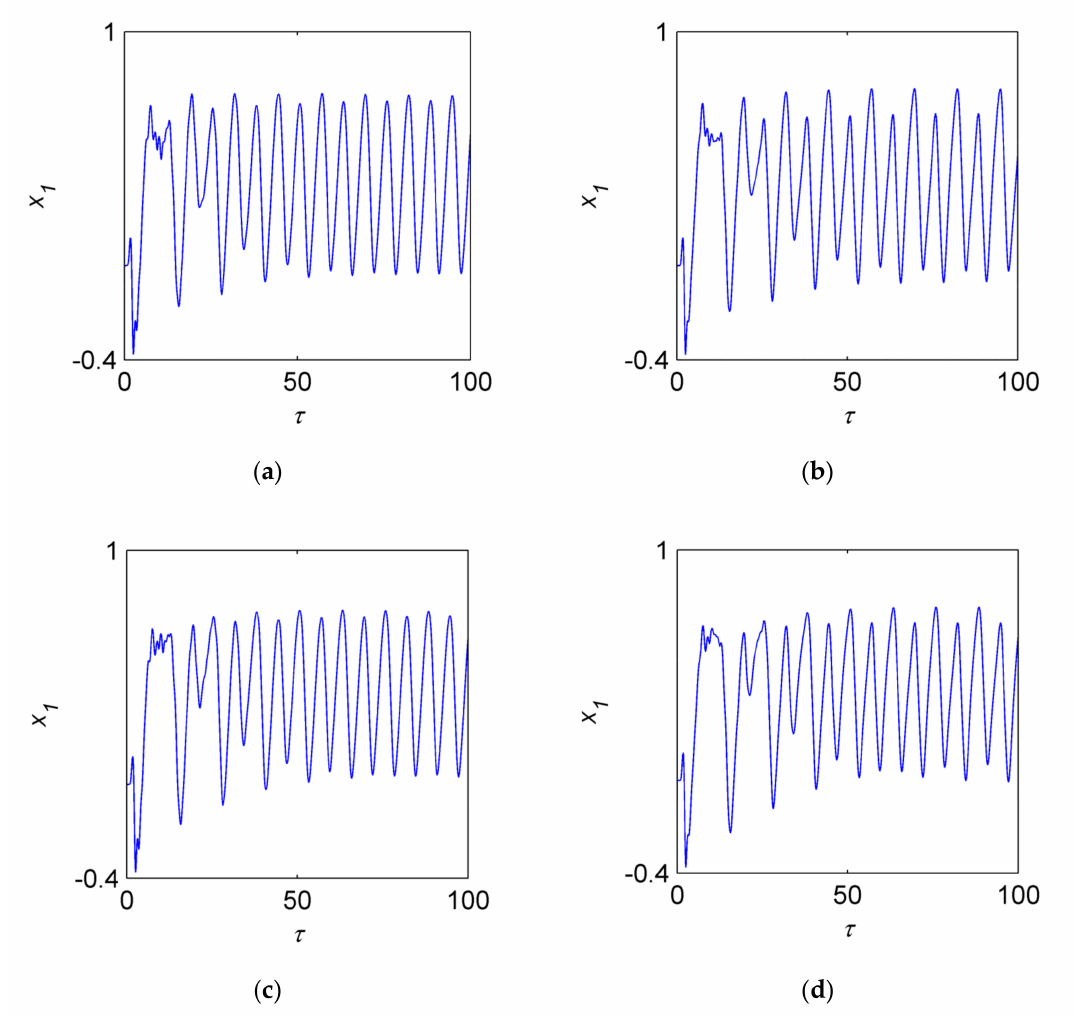
Figure 8. Time history curves of x 1 when ω = 730 rad/s. ( a ) The oil-filmed system. ( b ) The cracked system. ( c ) The rub-impacted system. ( d ) The coupled